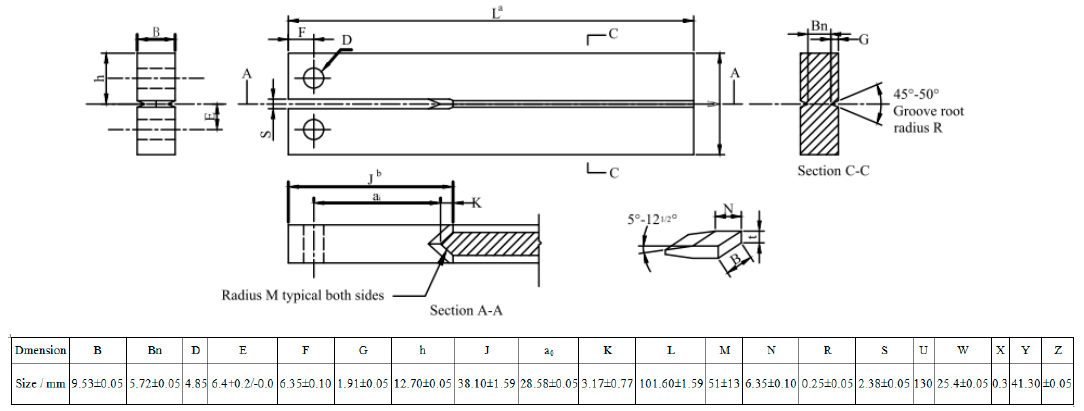
Figure 16. Typical illustration of standard DCB specimen.